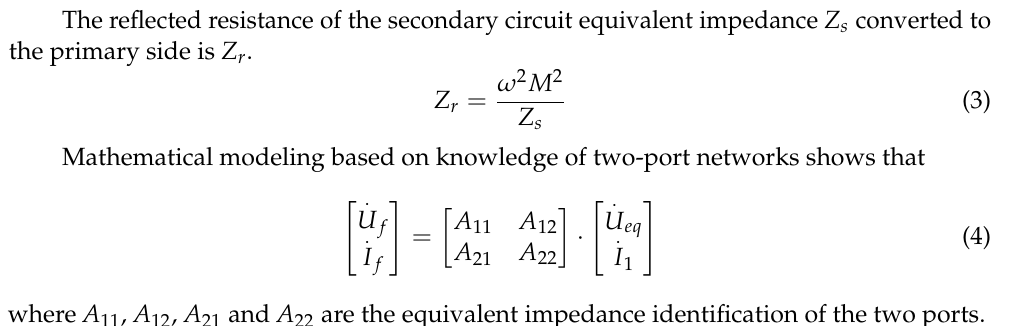
Figure 9. LCC-S type primary side equivalent circuit diagram.